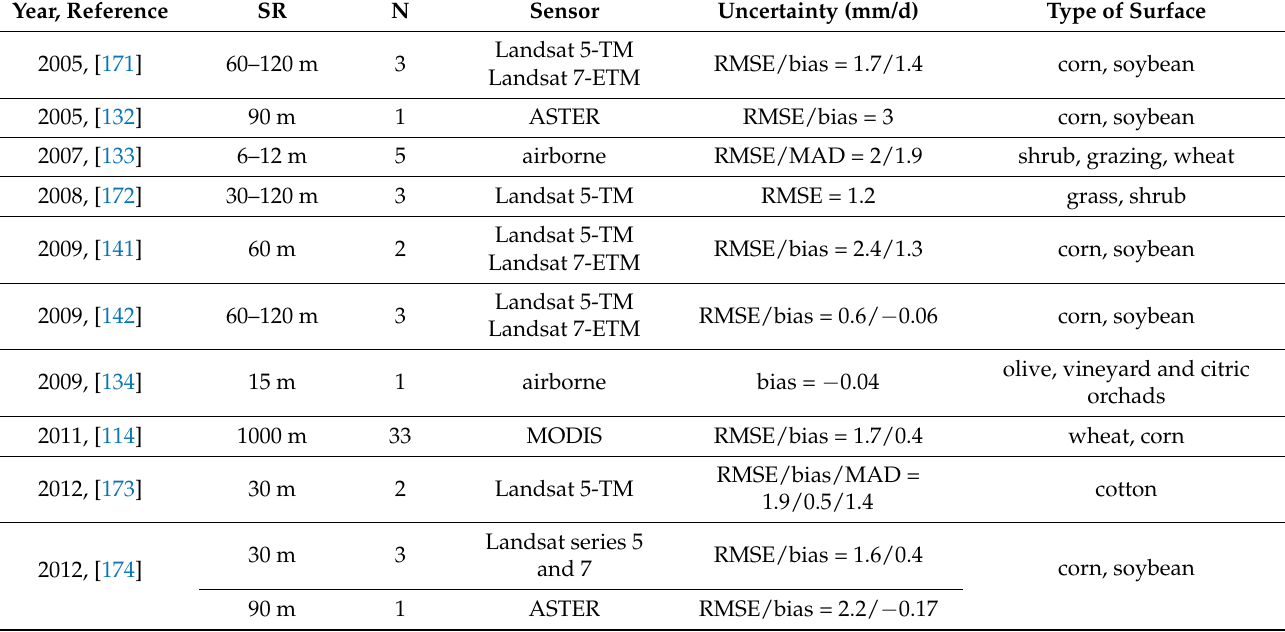
Table 6. Representative chronological compendium of validation studies of the TSEB model. Ref- erence, spatial resolution (SR), number (N) of satellite scenes, Sensor Name, Uncertainty and Type of Surface are detailed (uncertainty statistics are averaged values of all type of surface studied). Statistical uncertainties Root Mean Square Error (RMSE), bias and Mean Absolute Difference (MAD), are shown for ET d (mm/d). Different uncertainty rows inside the cell means uncertainty associated to the satellite